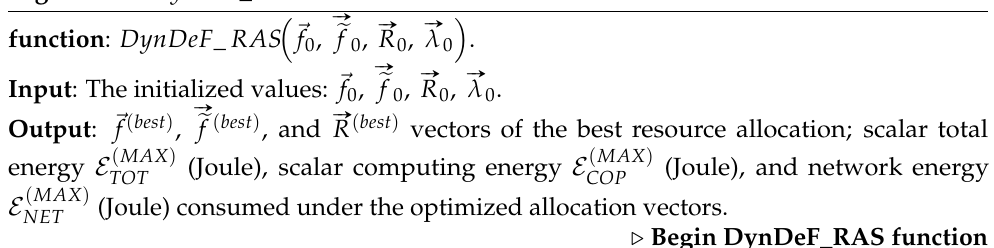
Algorithm 1 DynDeF_RAS